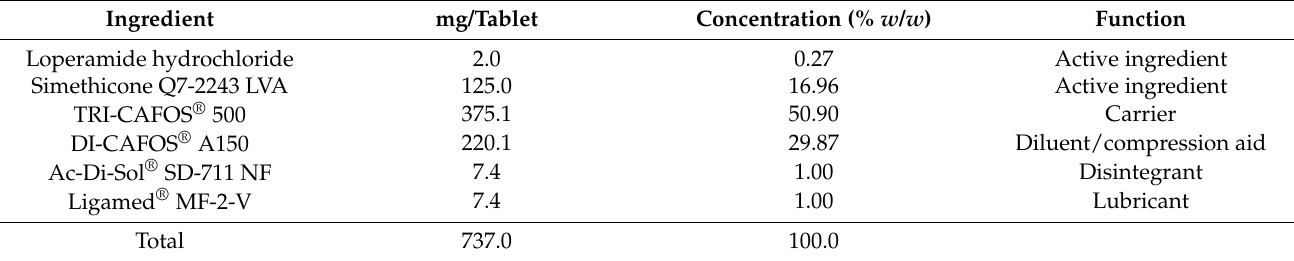
Table 2. Composition of simethicone and loperamide hydrochloride liquisolid